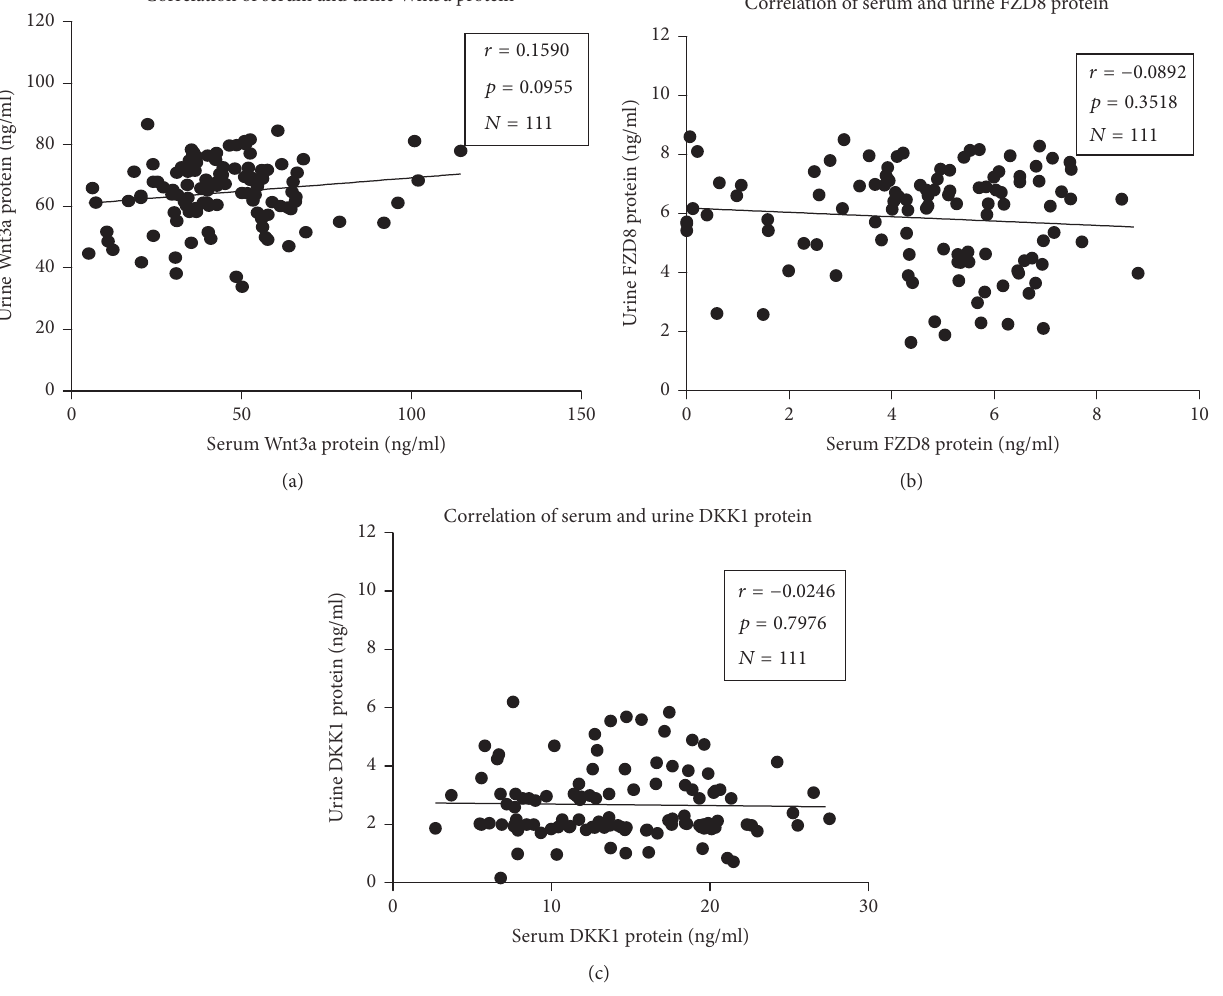
Figure 3: Correlations between serum and urine concentrations of Wnt-3A, FZD-8, and DKK-1. (a) Correlation between Wnt-3A protein levels in serum and urine. (b) Correlation between FZD-8 protein levels in serum and urine. (c) Correlation between DKK-1 protein levels in serum and urine. No significant correlation was determined between the serum and urine for all the three tested proteins. Spearman 𝑟 and 𝑝 values are displayed on each graph. A 𝑝 value was determined by the two-tailed Pearson correlation